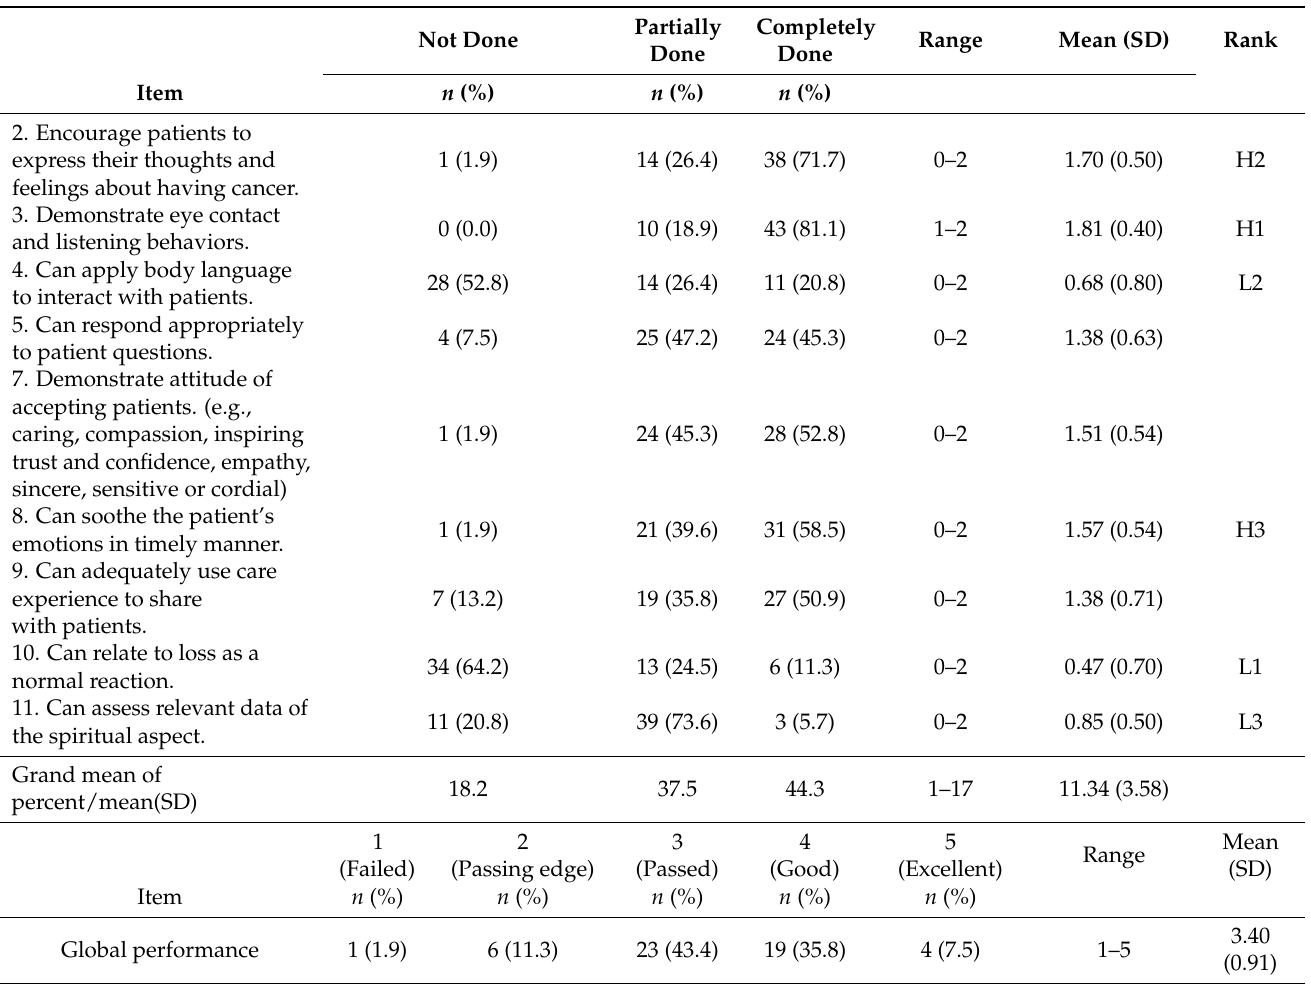
Table A5. OSCE scores of the experimental group on spiritual assessment ( n =